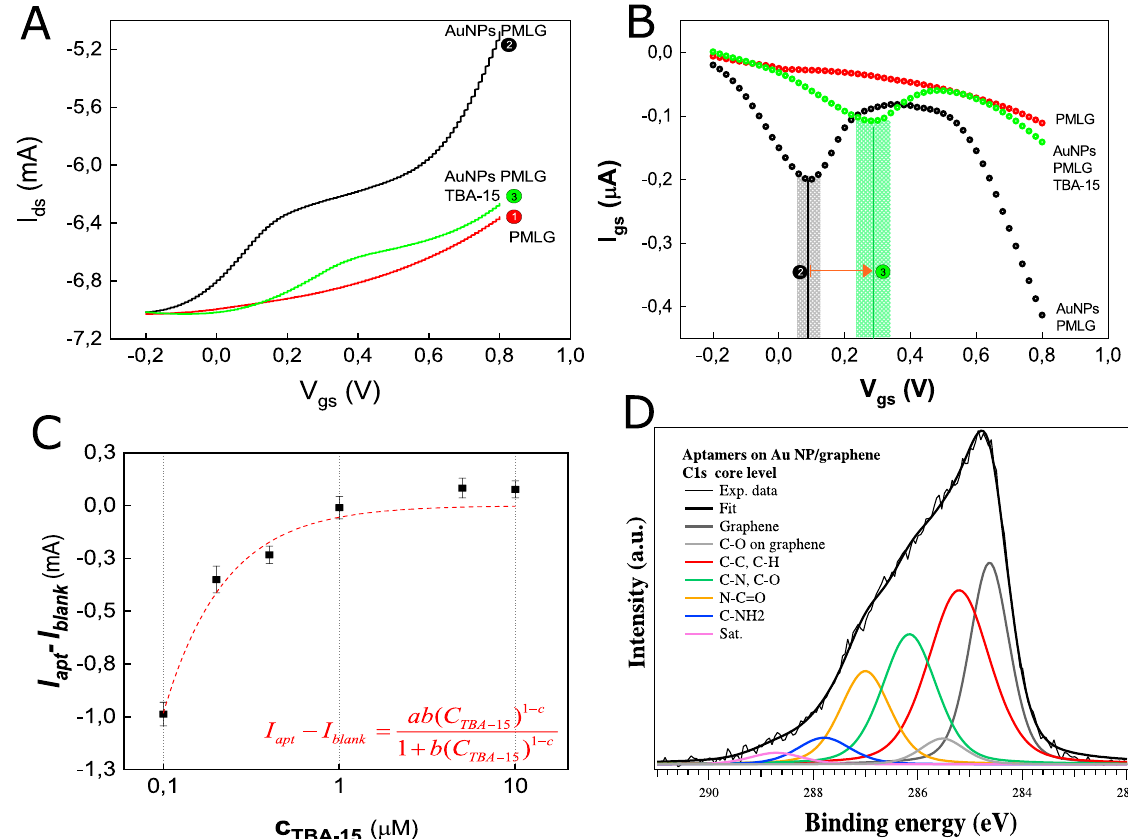
Figure 2. ( A ) comparison between the transfer curves for the different gate electrodes (i.e. unfolded TBA15- functionalized AuNPs-PMLG gate electrode (concentration 1 μM—green lines), bare PMLG (red lines) and AuNPs-PMLG (black lines)) and ( B ) related gate currents. Relative peaks are indicated with (2) for the AuNPs- PMLG and (3) for TBA15-functionalized AuNPs-PMLG gate electrode; ( C ) Optimization of the I apt − I blank parameter as a function of the aptamer concentration (fitting curve:Langmuir isotherm,red line); ( D ) C1s core level XPS analysis of PMLG/AuNPs/TBA-15. Single components are described in the